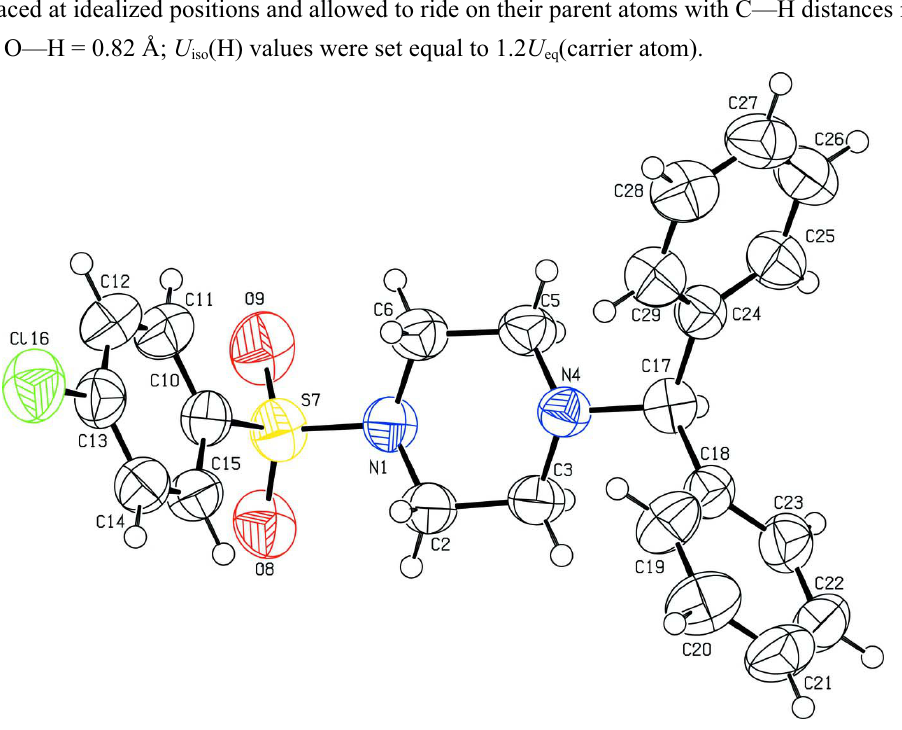
Figure 1 The molecular structure, with atomic numbering scheme. Displacement ellipsoids are drawn at the 50% probability level. H atoms are represented as small spheres of arbitrary